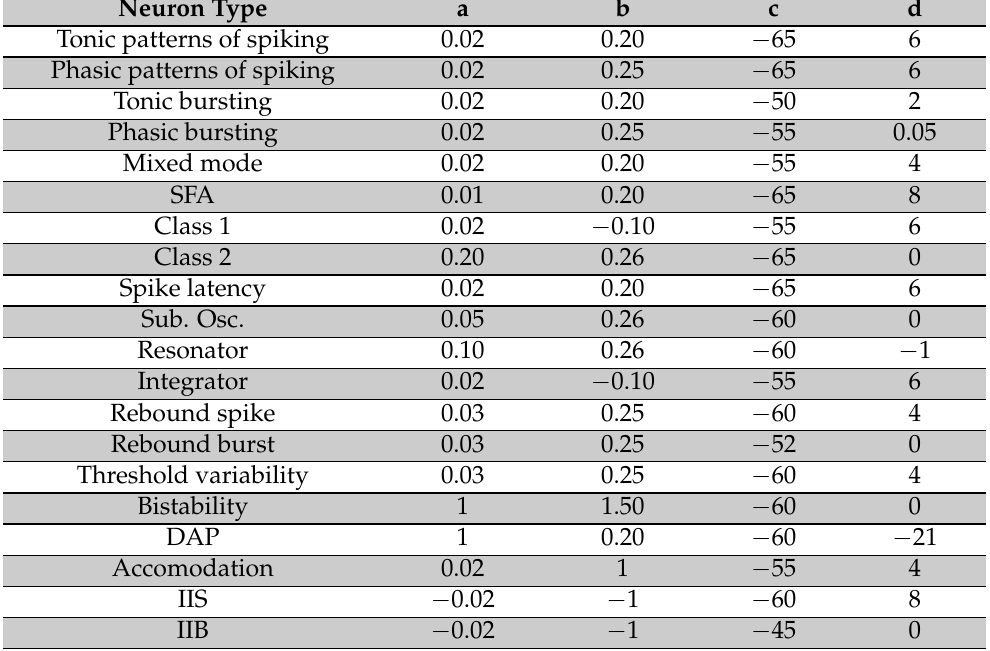
Table 1. Suitable parameters for spiking signals in the Izhikevich neuron